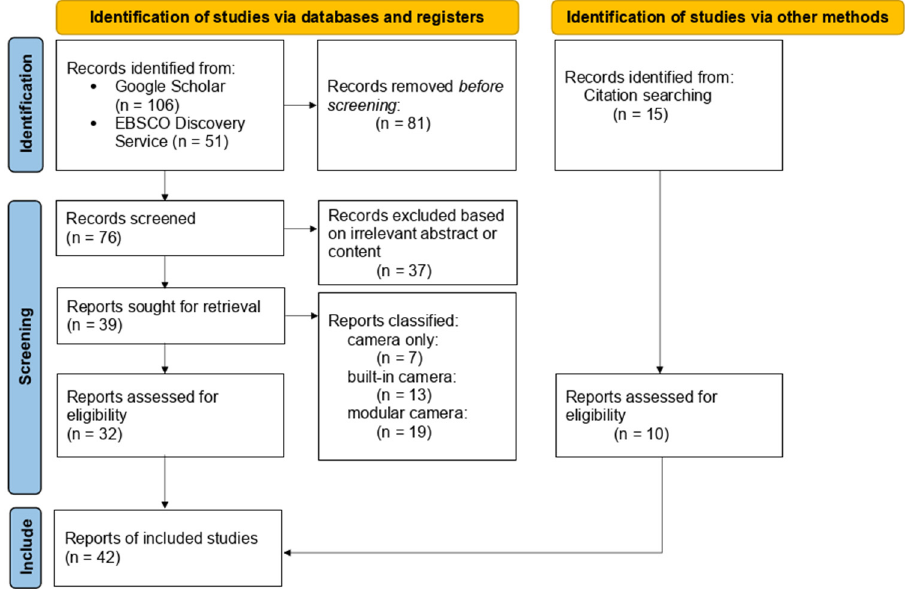
Figure 1. Chart for identifying relevant papers [20,21].